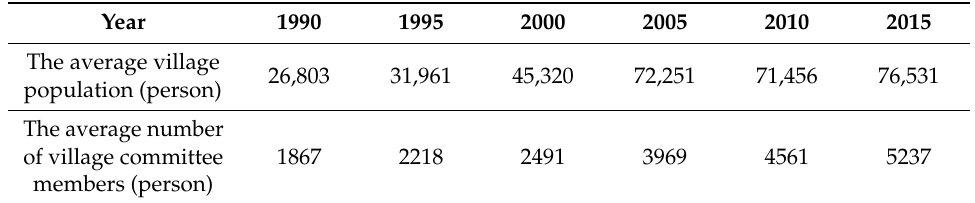
Table 6. Changes in the average village population and number of village committee members in the suburbs of